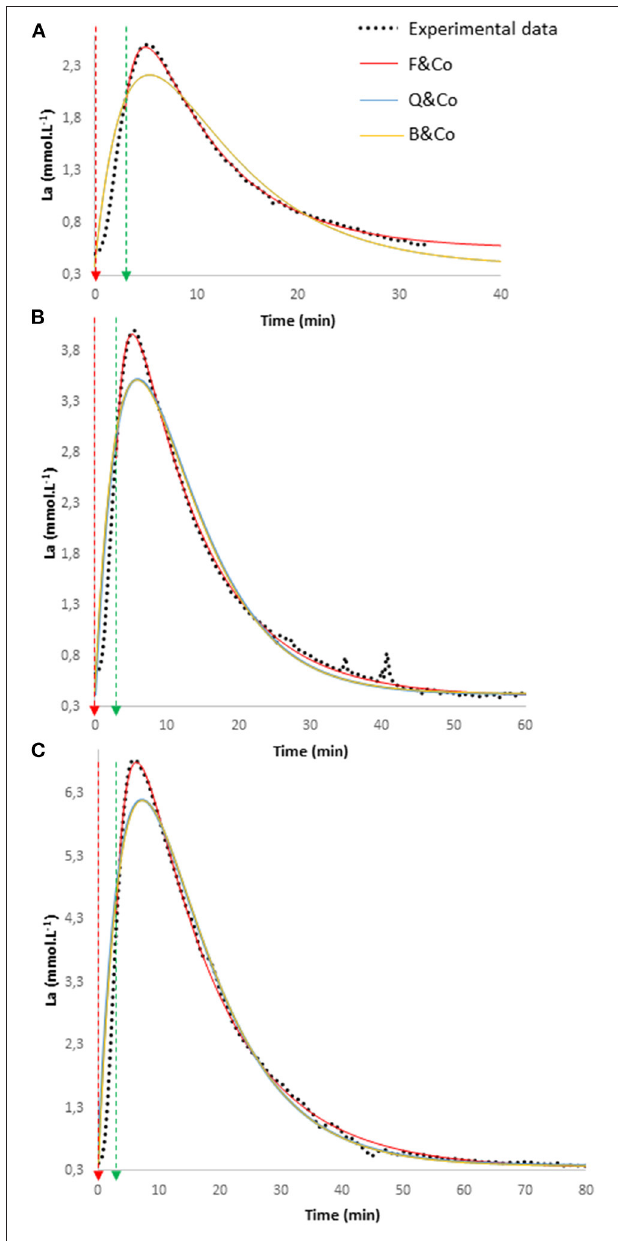
FIGURE 2 | Three experimental blood lactate concentration (La) curves obtained in the same subject during 3-min exercises and the following recoveries at three different exercise intensities [easy (A) , moderate (B) , and heavy (C) , respectively] and the fits from Equations 1–3 applied over the entire period of recovery (for F&co) and taking also into account the initial blood lactate concentration at the beginning of exercise (for B&co and